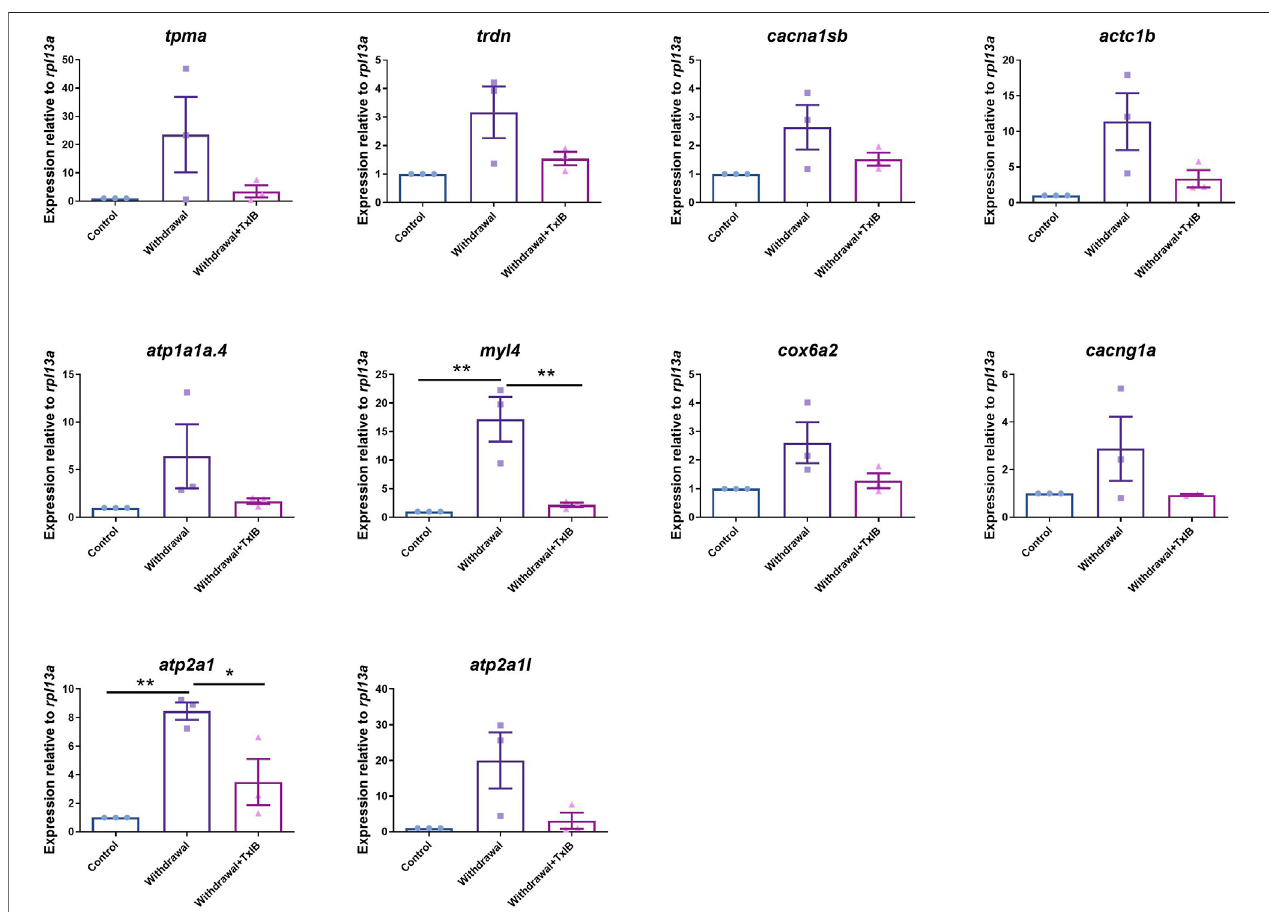
FIGURE 7 | The expression level of genes in calcium signaling and cardiac muscle contraction pathway using RT-PCR. TxIB concentration of 1 mg/kg was used. Data are mean ± SEM of 3 samples per group. * indicates p < 0.05, ** indicates p < 0.01 (one-way ANOVA followed by Tukey ’ s multiple comparisons test).